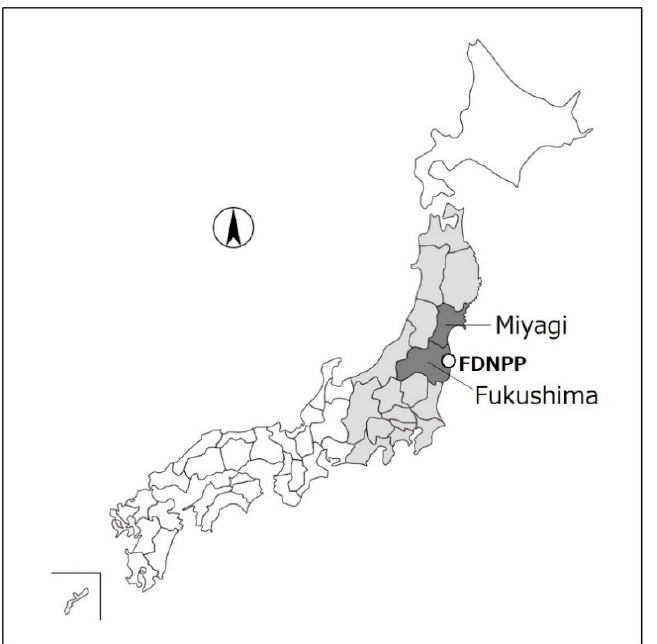
Figure 1. Location of Fukushima and Miyagi Prefectures (dark gray-colored area). The monitoring tests have been performed throughout Japan with a focus on 17 prefectures (dark and light gray- colored area).